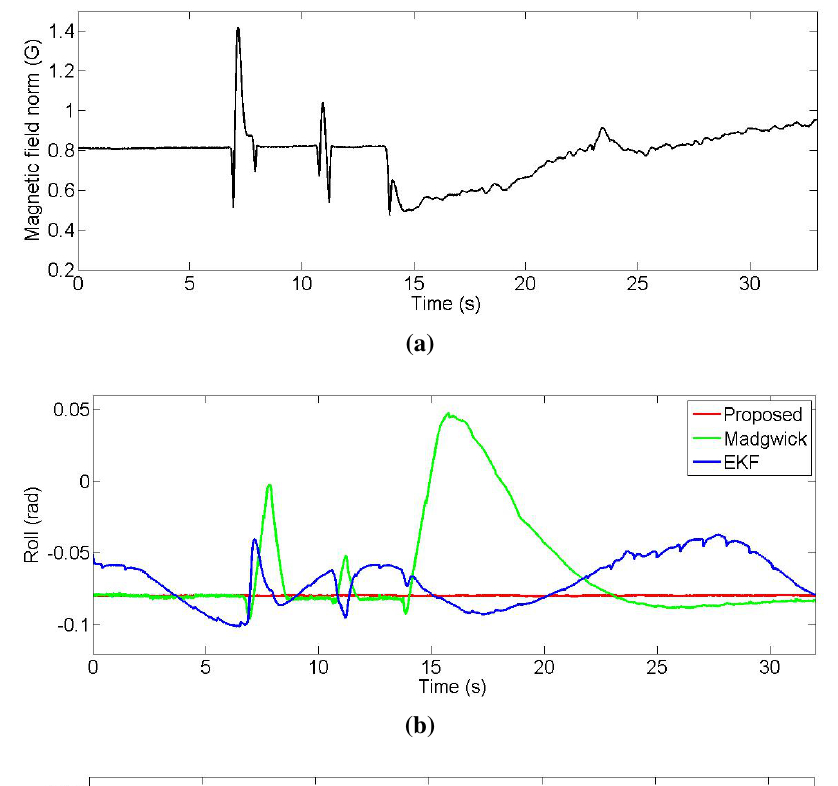
forces measured by the IMU are completely decoupled: gravitational acceleration on the z -axis, and total body motion acceleration on the x -axis.